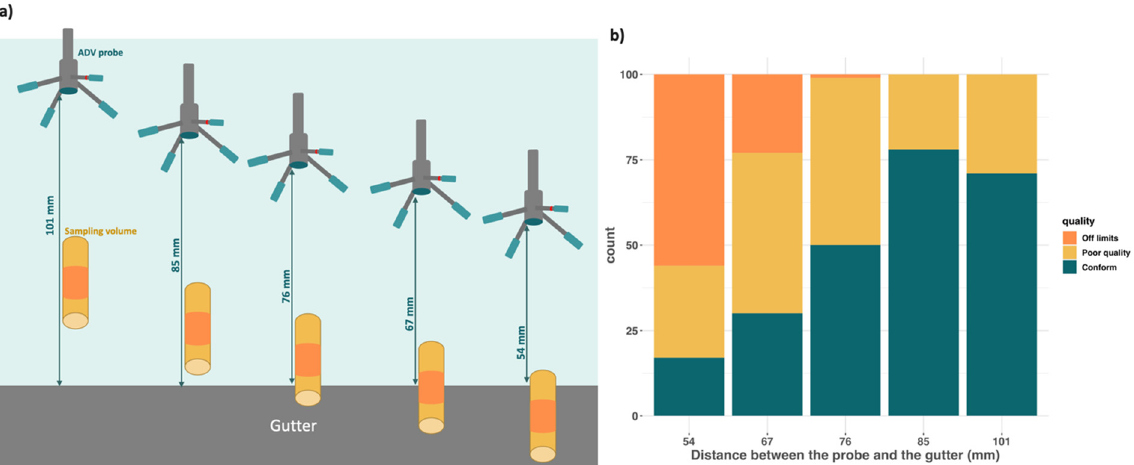
Figure 6. Probe height test. ( a ) Illustration of the probe position in relation to the gutter and the associated sampling volume (yellow). ( b ) ADV data quality, expressed in percentage, based on the probe height above the gutter.